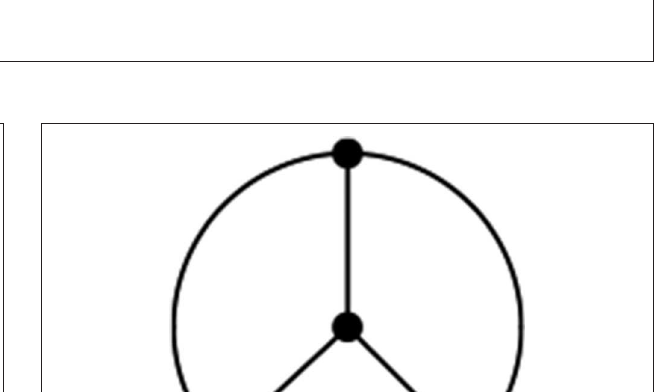
FIGURE 3 | The graphs G 6 i ( i